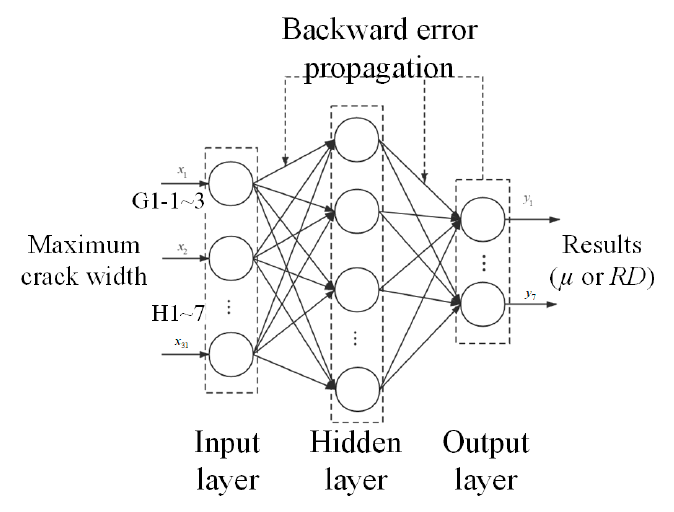
Figure 16. Backpropagation network.